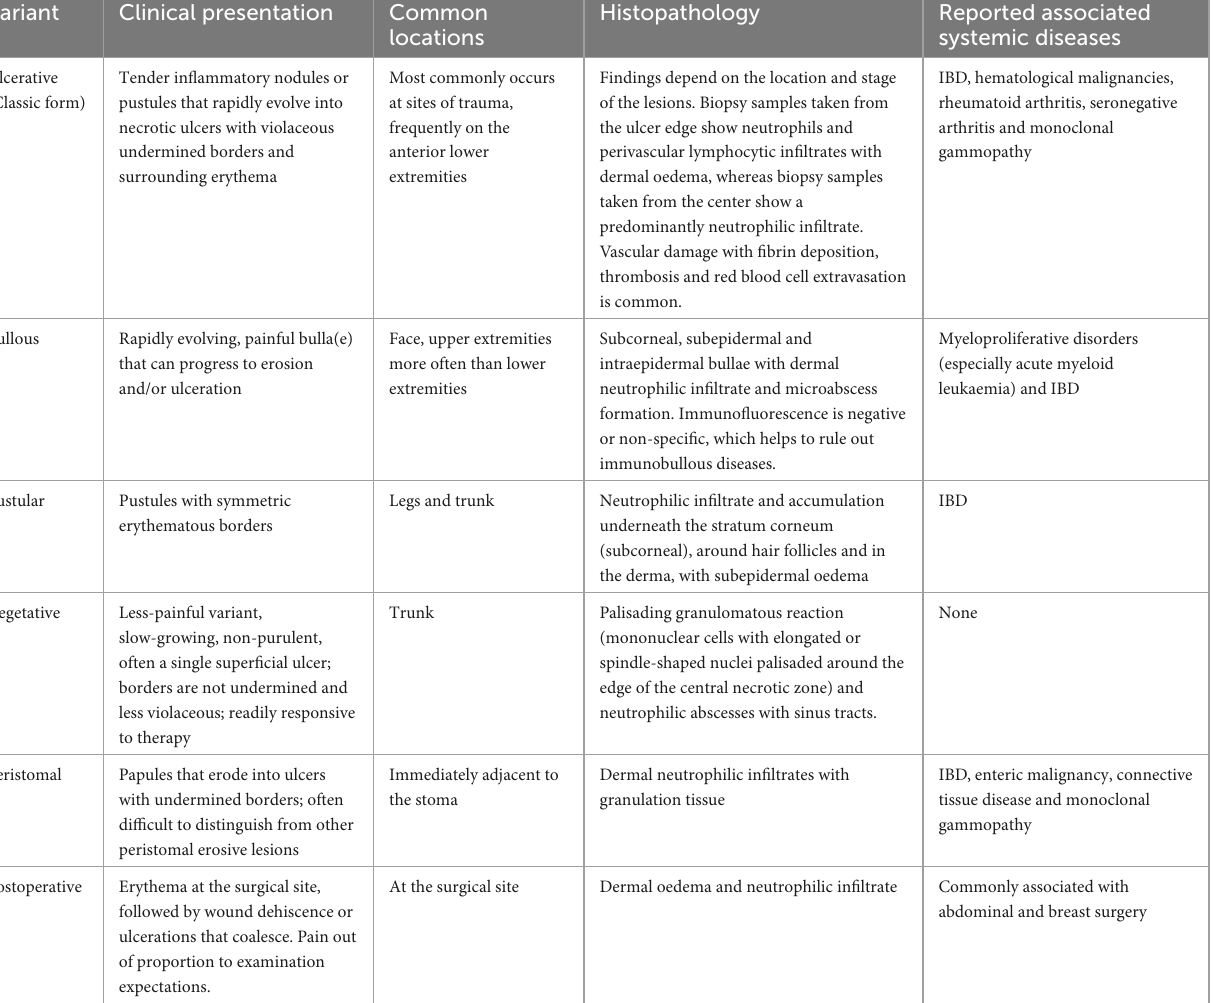
TABLE 1 Clinical variants of PG (23, 25,